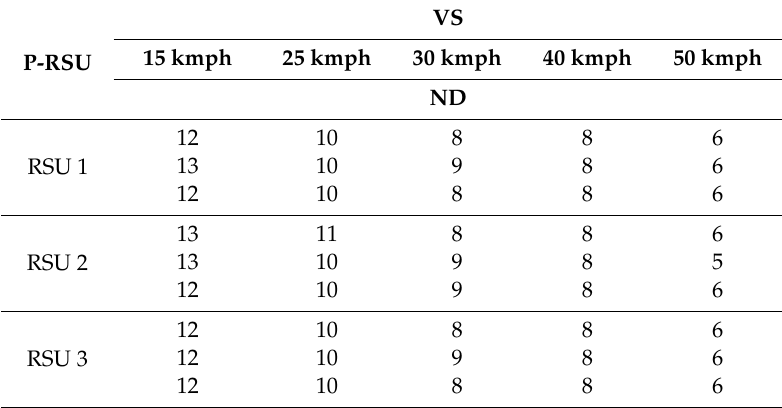
Table 4. Data used in two factorial design